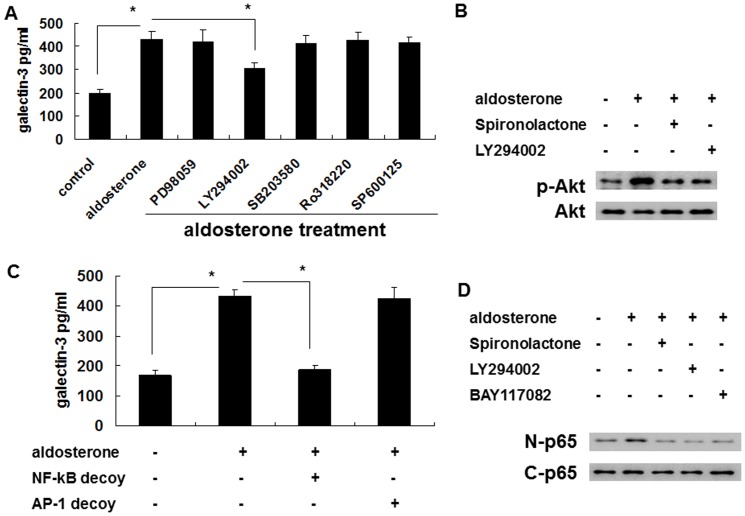
Aldosterone induced galectin-3 expression in Raw 264.7 cells via a MR/PI3K/Akt/NF-kB signaling pathway.(A) Aldosterone induced galectin-3 expression in Raw 264.7 cells via the PI3K/Akt signaling pathway. Raw 264.7 cells were serum-starved for 24 h and then pre-treated with PD98059 (50 µg/ml), LY294002 (50 µg/ml), SB203580 (5 µg/ml), Ro318220 (5 nM), and SP600125 (10 µM) for 1 h prior to 5×10−7 M aldosterone or vehicle treatment for 24 h. (B) Aldosterone induced Akt phosphorylation via MR-mediated signaling. Raw 264.7 cells were serum-starved for 24 h, then pre-treated with different chemical inhibitors for 1 h prior to 5×10−7 M aldosterone or vehicle treatment. After 30 minutes, total protein was collected and the expression level of the indicated protein was measured by Western blot with specific antibodies. (C) NF-κB was a prerequisite transcriptional factor in aldosterone-mediated galectin-3 expression. Raw 264.7 cells were transfected with NF-κB decoy ODN, AP-1 decoy ODN and serum starved for 24 h, then treated with 5×10−7 M aldosterone for another 24 h. *
P<0.05. (D) Aldosterone activated NF-κB via MR/PI3K/Akt signaling. Raw 264.7 cells were serum-starved for 24 h and then pre-treated with 10−7 M of spironolactone, LY294002 (50 µg/ml) or BAY117082 (10 µM) for 1 h before 5×10−7 M aldosterone treatment. Nuclear and cytosolic proteins were collected after 1 h, and the level of the NF-κB p65 subunit was determined by Western blotting. MR = mineralocorticoid receptor; nuclear (N) p65 and cytosol (C) p65.